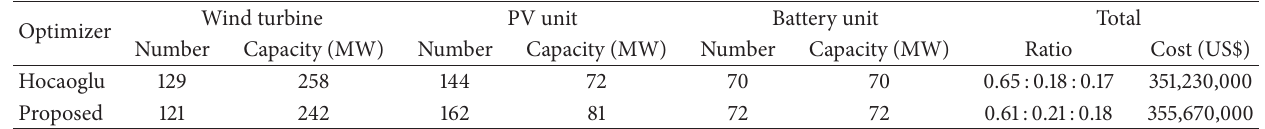
Table 4: The contrast of optimal configuration result.